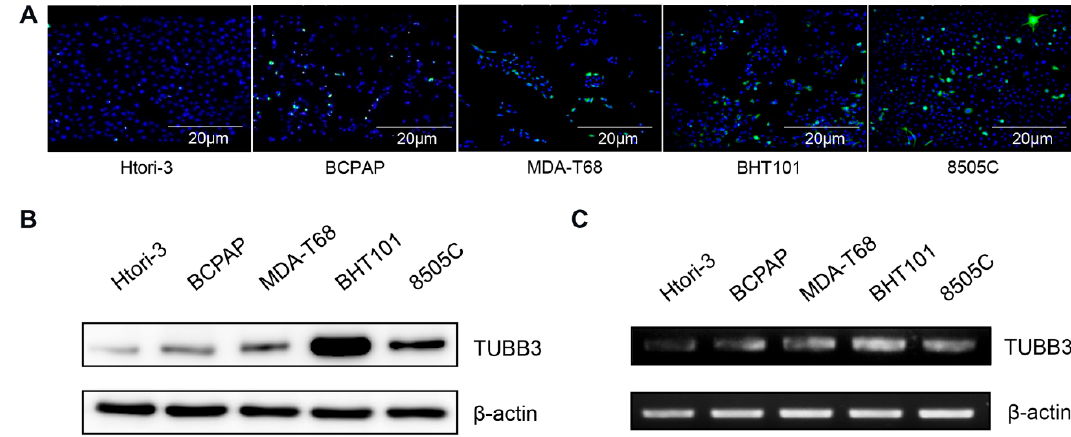
Figure 4. Western blot and RT-PCR in normal thyroid cells and thyroid cancer cells at baseline. ( A )